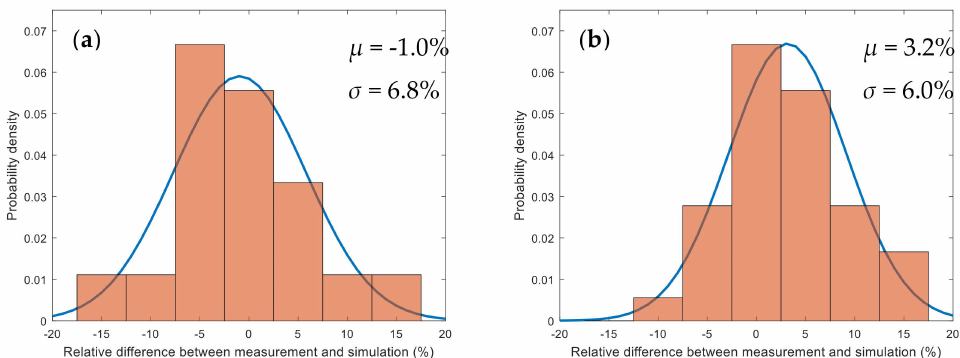
Figure 8. Comparison of measurement and simulation for transition overvoltages upon energizing from nearby substation: ( a ) Results for the substation; ( b ) Results for the two transition